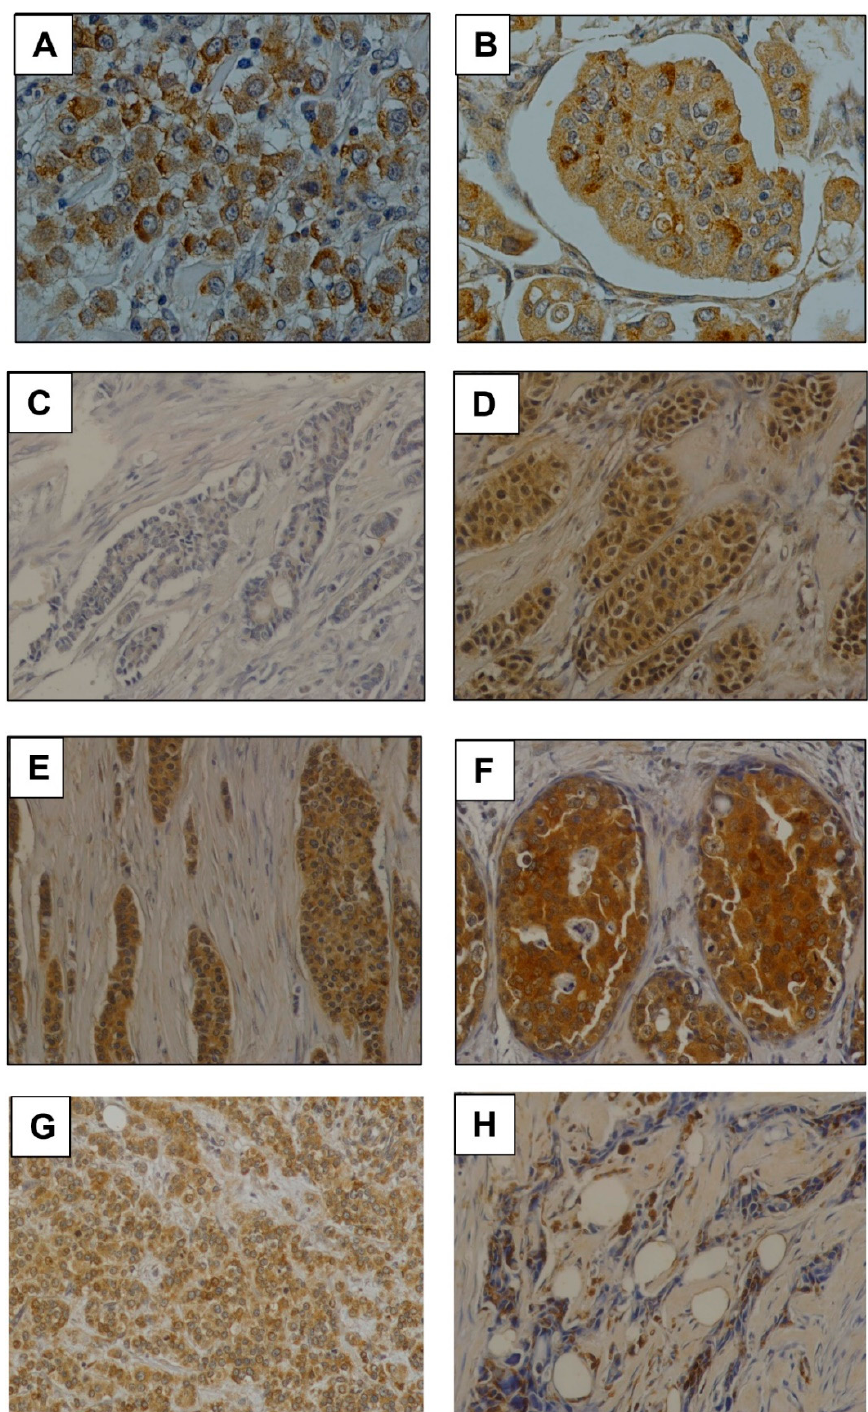
Figure 3. Monoclonal antibody T13.5 immunostaining in breast cancer. ( A , B ) Immunostaining of anti-GalNAc-T13 MAb showing diffuse and granular cytoplasmic pattern and several perinuclear reinforcements. Both pictures have been taken at 400x magnification. ( C – F ) Examples of immunostaining intensity: (-), (+), (++) and (+++), respectively. ( G ) Immunostaining in a high percentage of cells. ( H ) Focal immunostaining in a low percentage of cells. Pictures C – H have been taken at 200x magnification.